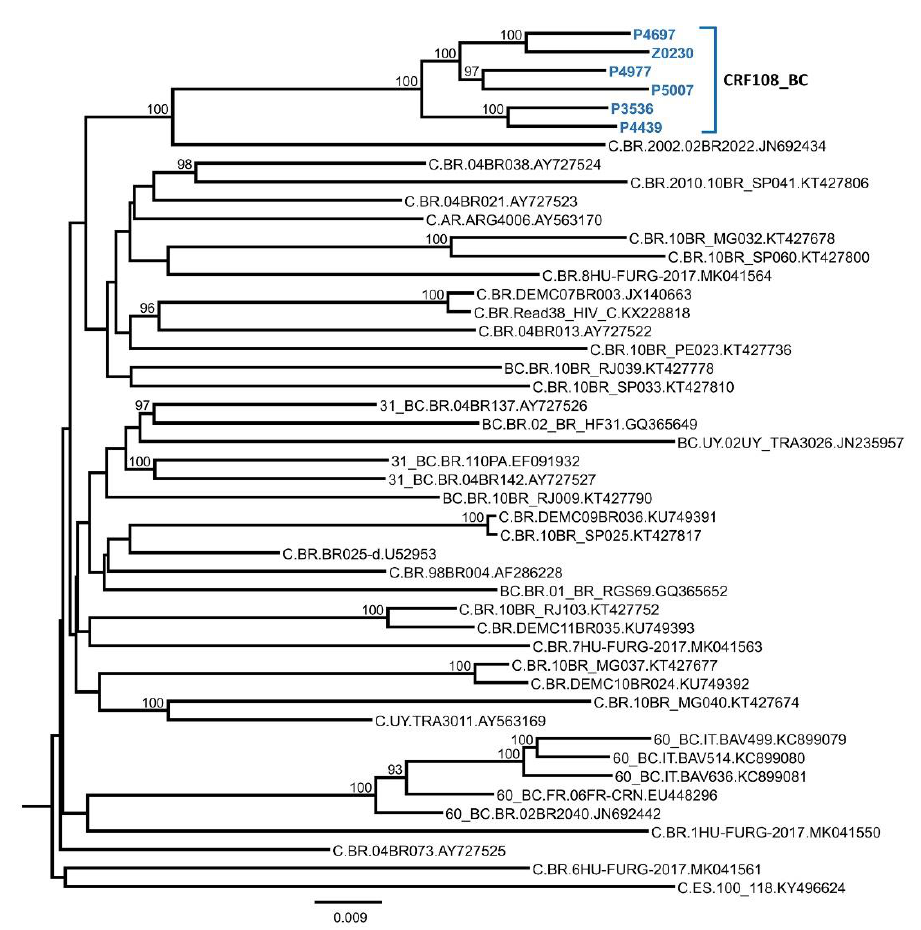
Figure 4. Phylogenetic tree of concatenated subtype C fragments of CRF108_BC. Only bootstrap values ≥ 90% are shown. CRF108_BC sequences are in blue and bold type. Database sequences are labeled with subtype, two-letter ISO code of the country of sample collection, virus name, and GenBank accession.